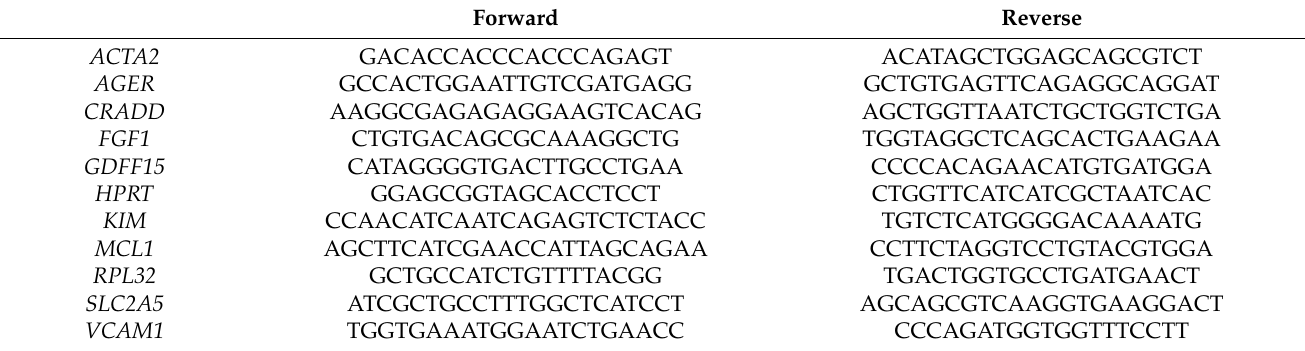
Table 1. List of sequences of the primers used in the RT-qPCR